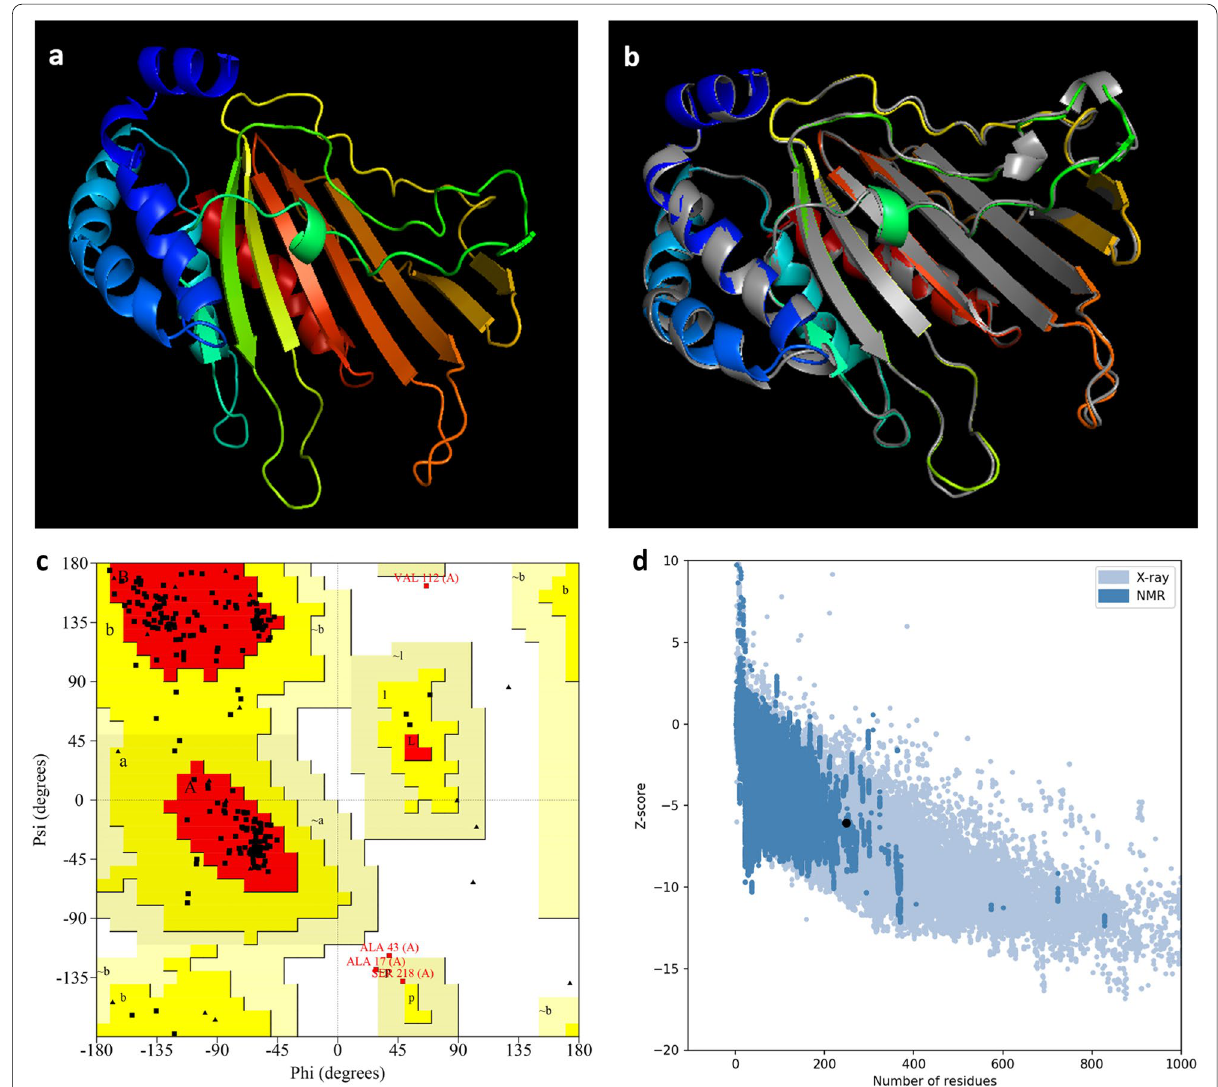
Fig. 6 a The 3D model of NHP1 protein obtained from Robetta server following homology modeling. b Refined model after refinement superimposition using Galaxy Refine-GalaxyWEB server. c Ramachandran plot for structural validation with 92.7% residues in the favored region. d ProSA-web, with a Z score of −